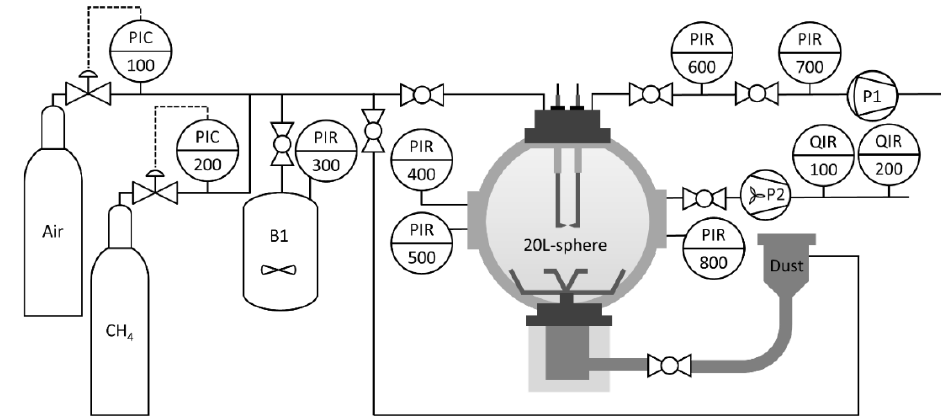
Figure 2. Schematic of the standard 20 L-sphere with adaptations for hybrid mixture testing, having premixtures inside a premixing vessel (B1) that can be filled to the 20 L-sphere and the dust container.